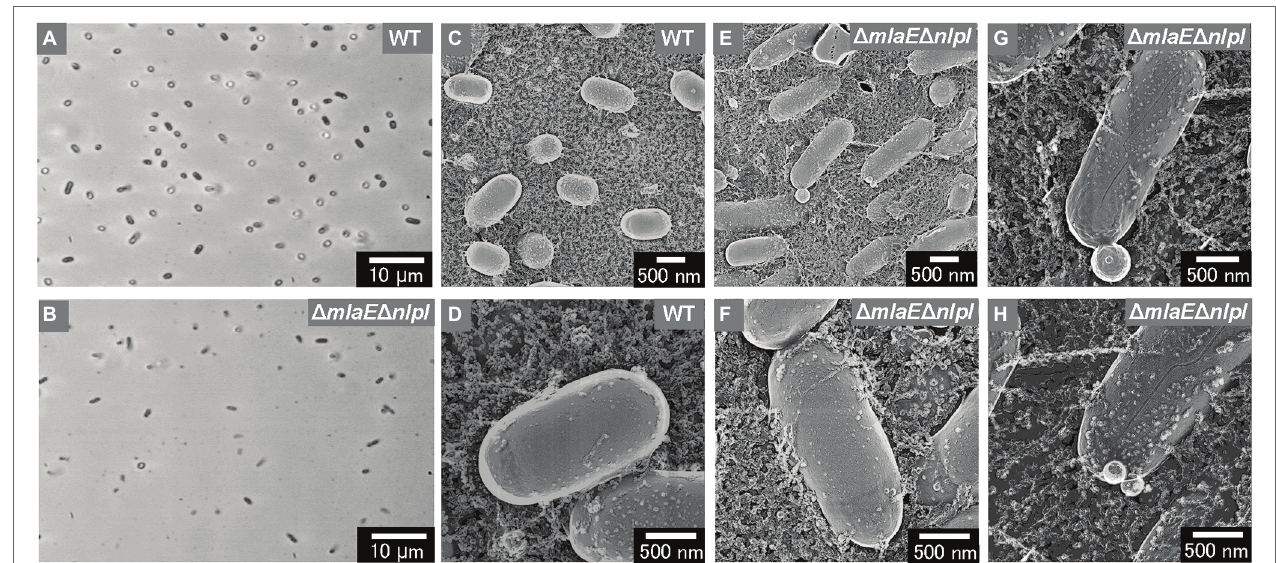
FIGURE 2 | Surface structure of the wild-type (WT) E. coli BW25113 and Δ mlaE Δ nlpI cells visualized via quick-freeze, deep-etch electron microscopy (QFDE-EM). (A,B) Phase-contrast optical microscopy image of the WT (A) and Δ mlaE Δ nlpI cells (B) . (C) Field image of the WT cells. (D) Magnified image of the surface of WT